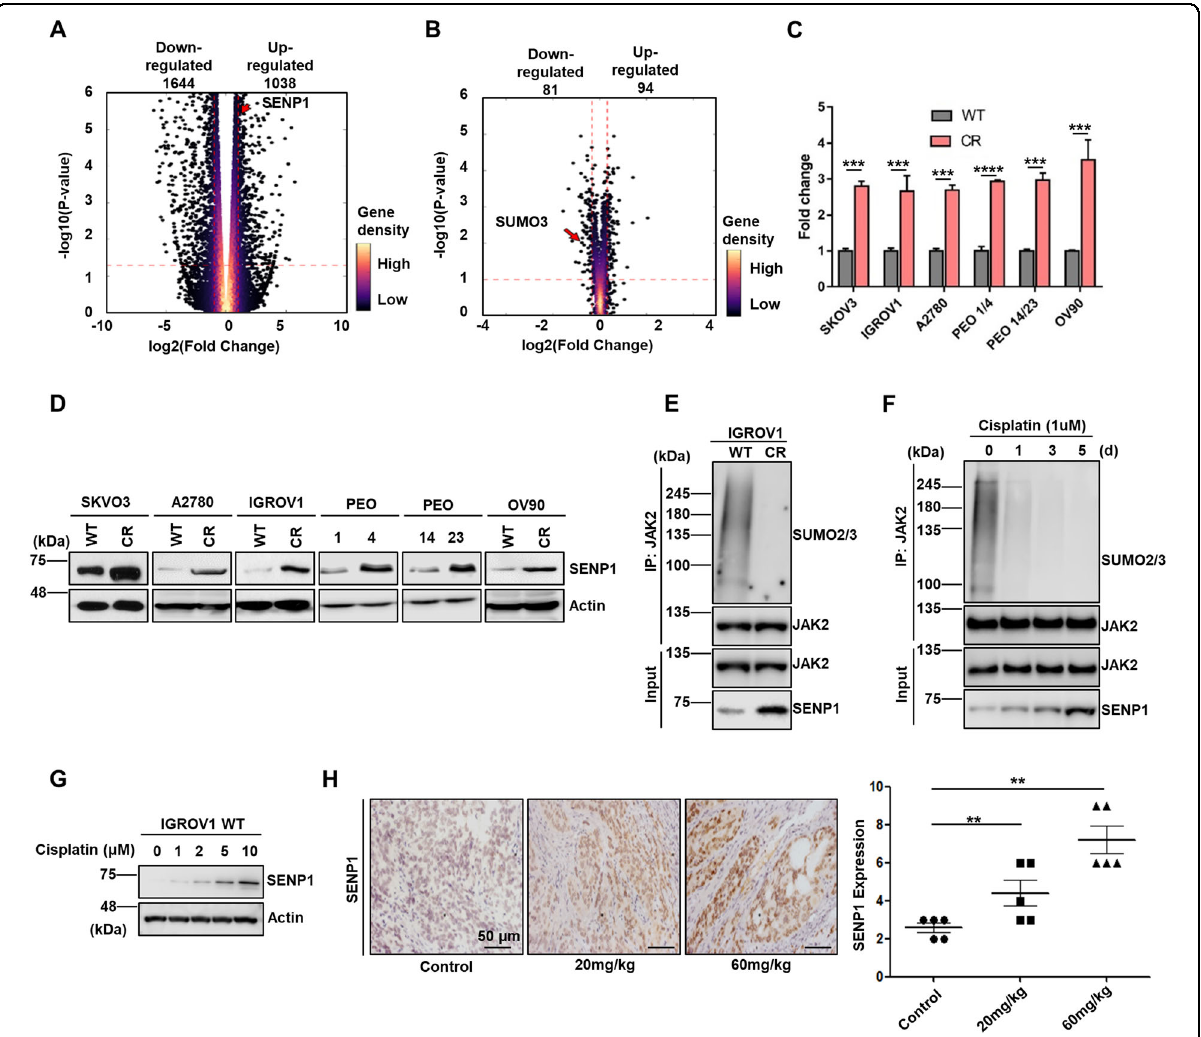
Fig. 4 SENP1 is upregulated in cisplatin resistant cancer cells. A Volcano plot of up-regulated and down-regulated genes identi fi ed from RNA- Seq assay using IGROV1 and IGROV1 CR cells. Genes are ranked in volcano plot according to their p-value and relative abundance ratio (log2 fold change). B Volcano plot of up-regulated and down-regulated genes identi fi ed by quantitative proteomics using IGROV1 and IGROV1 CR cells. Proteins are ranked in volcano plot according to their p-value and their relative abundance ratio (log2 fold change). C SENP1 mRNA expression levels are signi fi cantly upregulated in cisplatin resistant ovarian cancer cell lines. mRNA expression levels were assessed by qPCR. D SENP1 protein levels are upregulated in indicated paired cisplatin sensitive and resistant ovarian cancer cell lines. Cell lysates from indicated cells were Western blotted for indicated proteins. ***, p < 0.001; ****, p < 0.0001. E SUMOylation of JAK2 decreases in cisplatin-resistant IGROV1 cells. Cell lysates from IGROV1 and IGROV1 CR cells were Western blotted for indicated proteins. F SUMOylation of JAK2 decreases in IGROV1 cells treated with cisplatin. Cell lysates of IGROV1 CR cells treated with cisplatin at indicated time point were Western blotted for indicated proteins. G IGROV1 cells were treated with indicated amount of cisplatin, followed by Western blot for indicated proteins. H Representative IHC images of IGROV1 xenograft tumors treated with vehicle and carboplatin (20 mg/kg and 60 mg/kg). Scale bar: 50 µm. Right panel, Quanti fi cation of IHC staining for SENP1 in carboplatin treated mice. n = 5 mice/group. Data were represented as means ± SD ( n = 3). **, p <